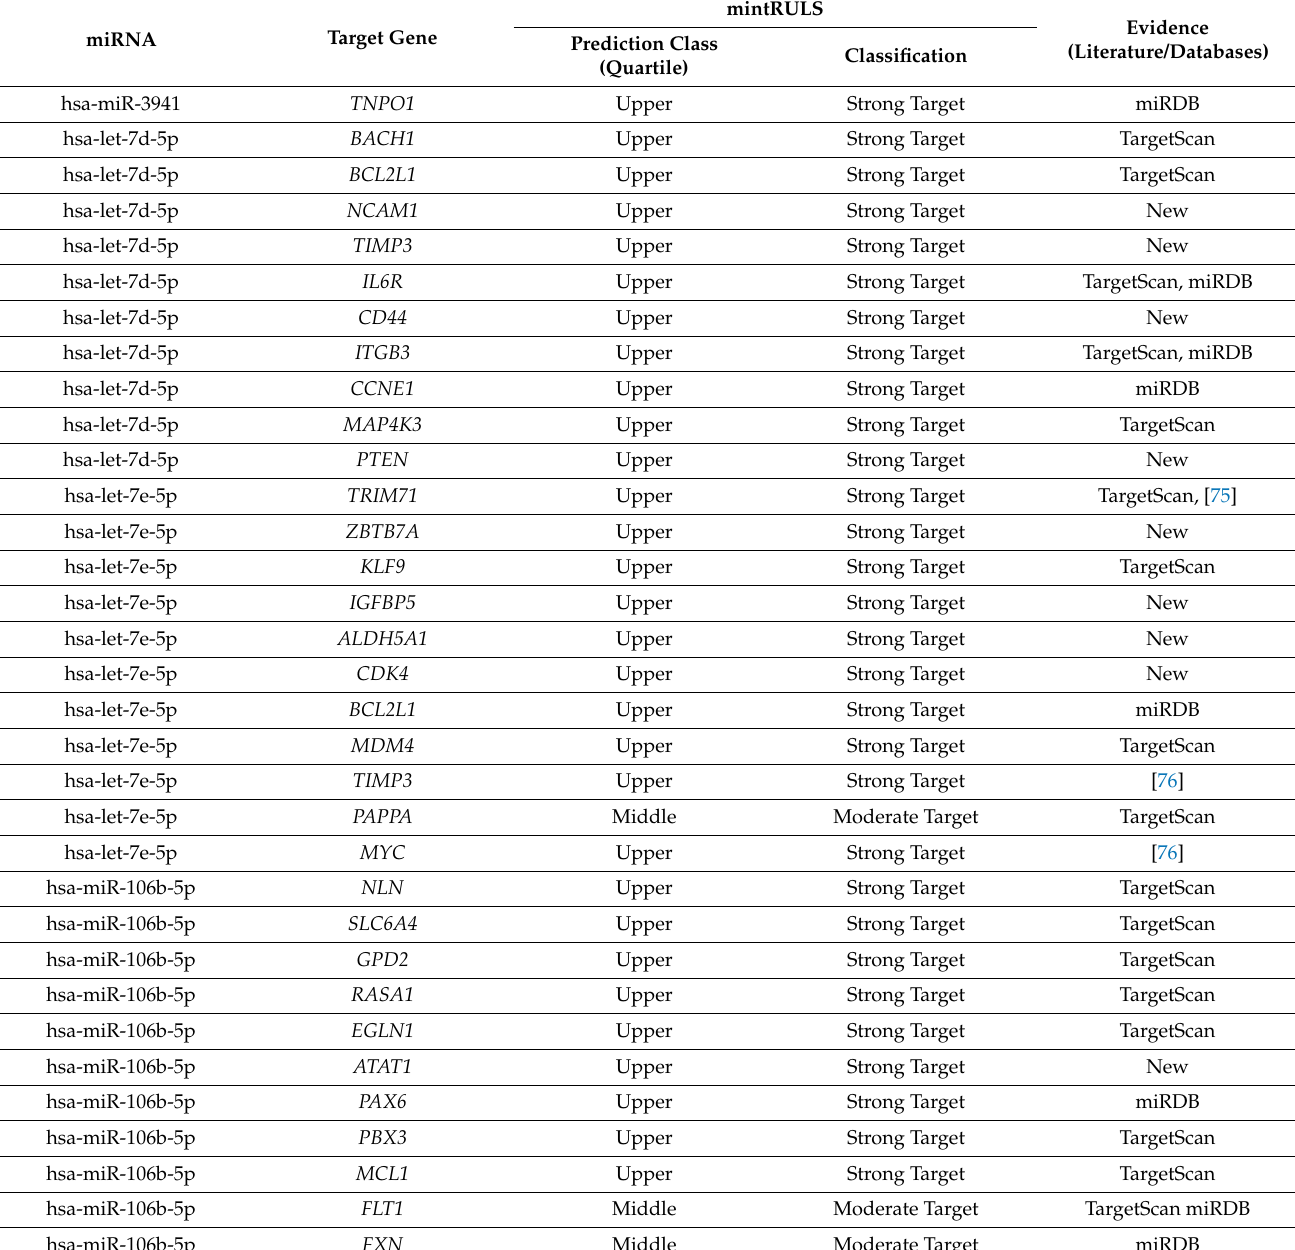
Table 4. miRNA–mRNA interactions predicted by mintRULS and supporting data in literature and